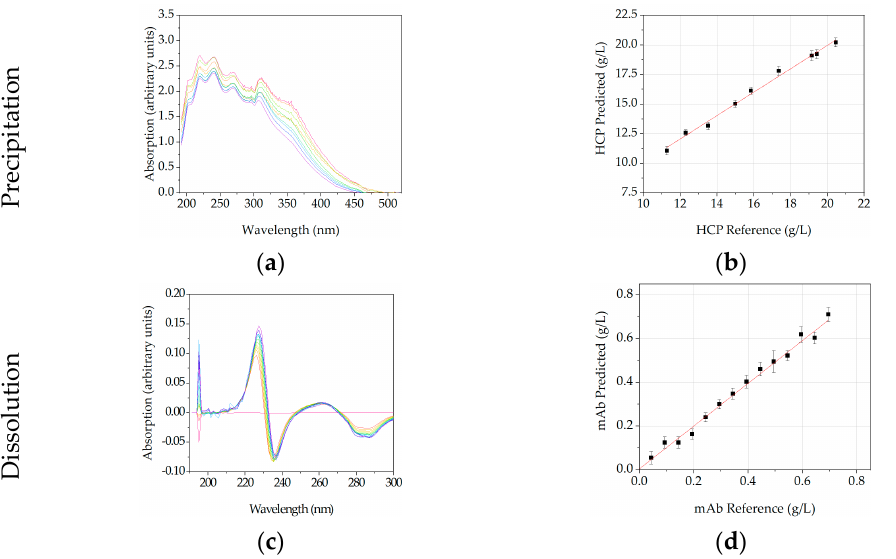
Figure 14. DAD spectral data for precipitation ( a , b ) and dissolution ( c , d ). Preprocessed spectral data are presented in ( a , c ). ( b , d ) show the PLS regression results of the prediction of the investigated CQAs. Different colors represent the spectral data for different samples and are sorted from red to blue. Sample names are equal to Figure 12. Spectral data ( c , d ) have been previously published [6].